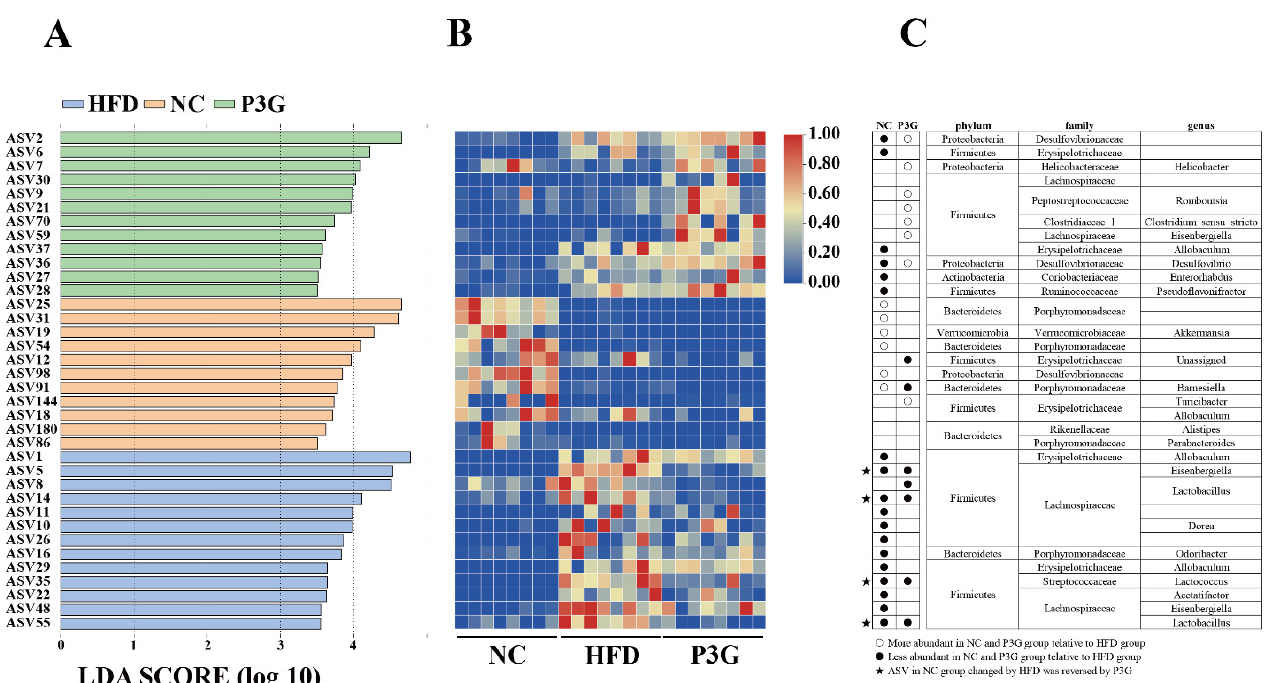
letter indicates no significance between the two groups, and different letters indicate significance ( p < 0.05).